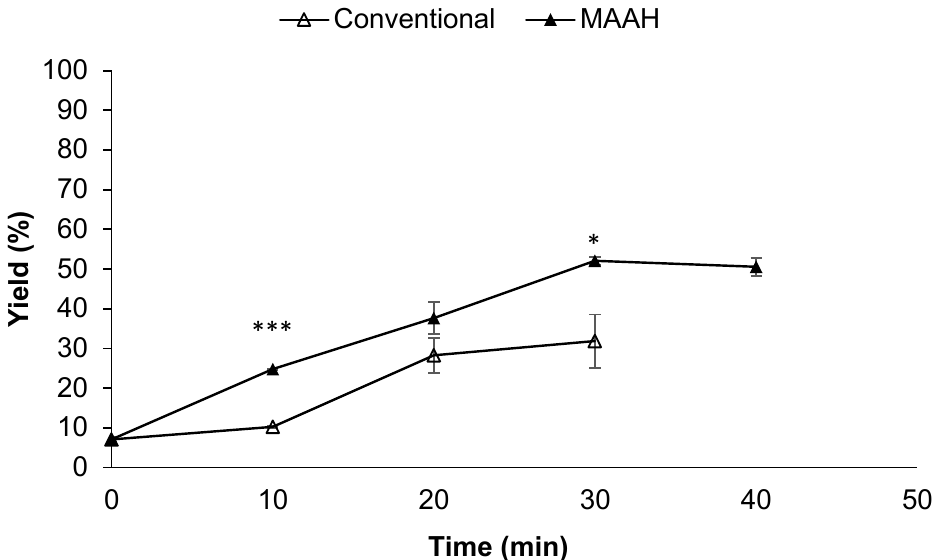
Figure 3. Hydrolysis extraction yield (%) of sapogenin-rich extracts from fenugreek obtained at different reaction times by conventional hydrolysis and microwave-assisted acid hydrolysis (MAAH) at 140 ◦ C. Standard deviations are indicated by error bars. Mean values at the same time of hydrolysis are significantly different if p ≤ 0.05 (*) or p < 0.001 (***).